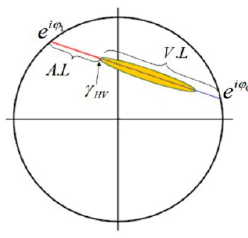
Figure 9. The ambiguous line segment and the visible line segment on the coherence line [7].